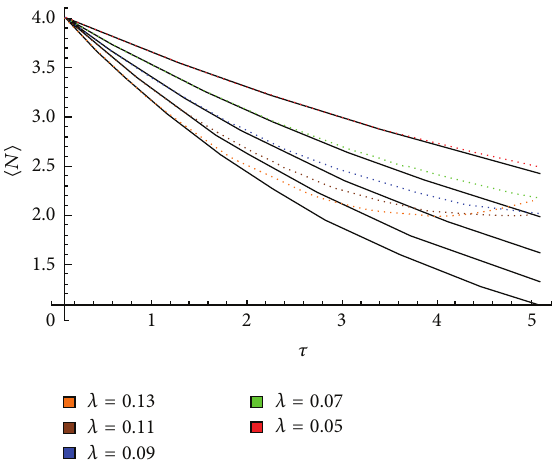
Figure 3: The mean photon number ⟨𝑁⟩ versus time 𝜏 , with 𝛼 = 2 and 𝜆 = 0.05, 0.07, 0.09, 0.11, and 0.13. The solid lines are for the exact solution, while the dotted lines are for the perturbative